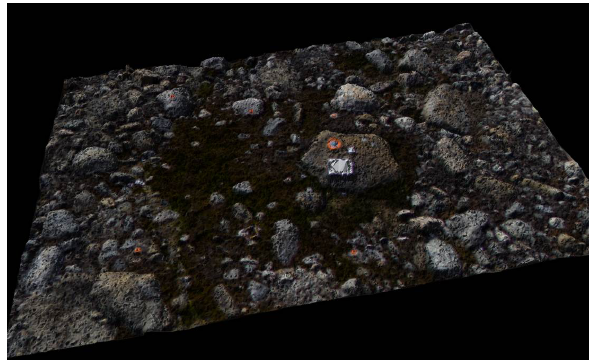
Figure 6: Terrain surface model derived from the point cloud. colour in the overlapping photographs. This surface was con- verted to a digital elevation model at 2 cm grid cell resolution.